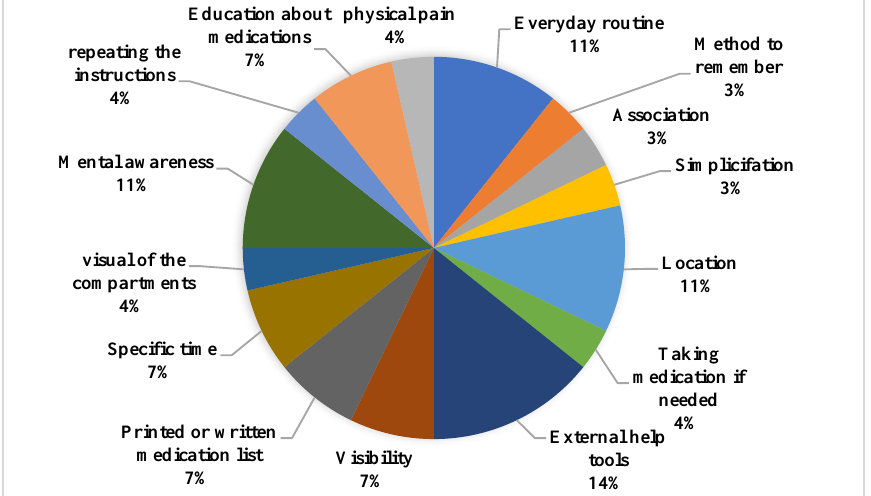
Figure 4. Compensation strategies of the included studies.